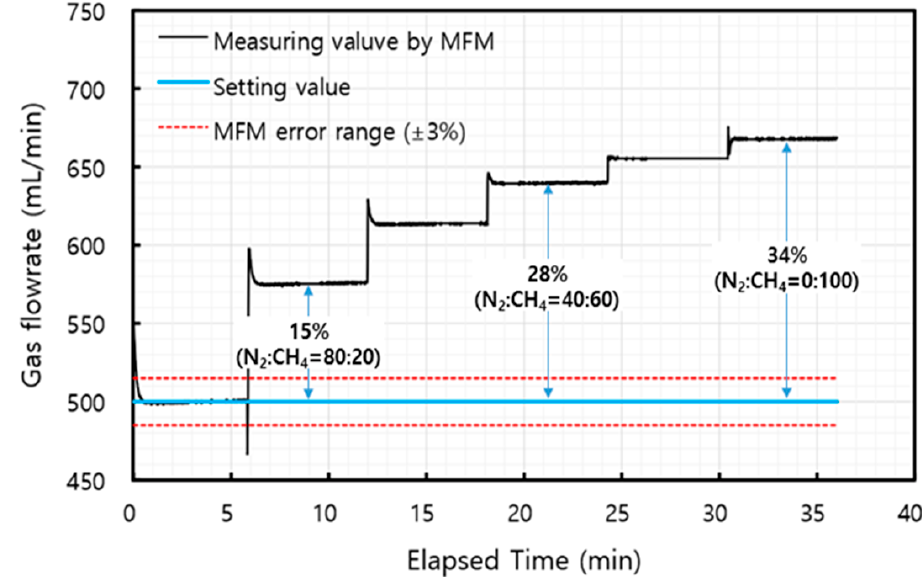
Figure 2. Gas flow rate measured by an MFM with changes in CH 4 mixing ratio.